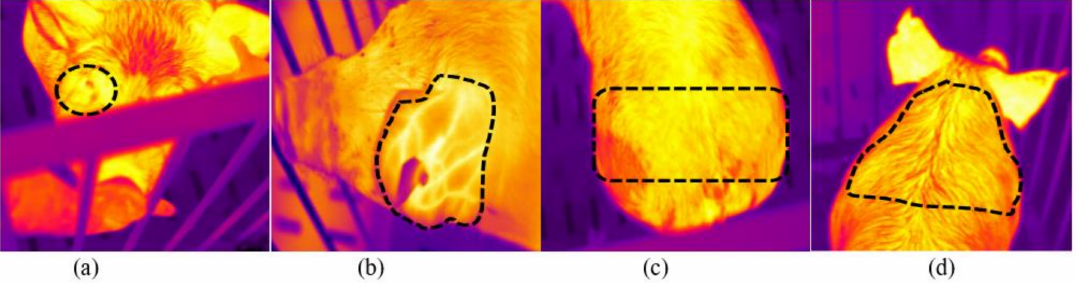
Figure 3. Anatomical sites used for the infrared thermography assessment: ( a ) Orbital region (infrared orbital temperature—IROT); ( b ) behind ears (infrared behind ears temperature—IRBET); ( c ) rump (infrared rump temperature—IRRT; and ( d ) neck (infrared neck